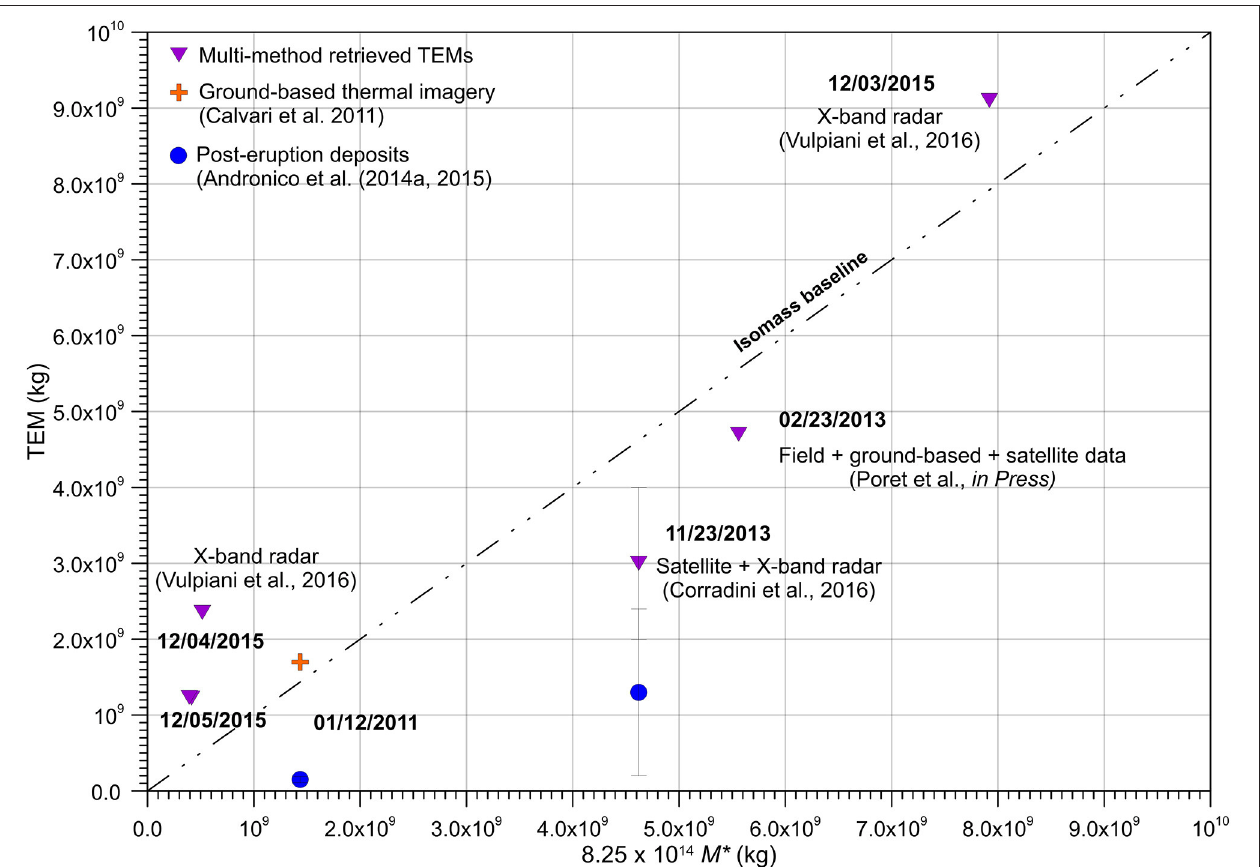
FIGURE 9 | Total Erupted tephra Mass (TEM) at Etna as a function of the calibrated mass proxy M * from the VOLDORAD 2B radar parameters. The isomass baseline appears as a dashed line. Purple triangles correspond to the mass obtained from X-band radar during four paroxysms of the VOR Crater in December 2015 (Vulpiani et al., 2016), X-band weather radar and satellite during the 23 November 2013 paroxysm (Corradini et al., 2016), and from an integration of field, dispersion model, ground-based and satellite data during the 23 February 2013 event (Poret et al., in press). Orange cross corresponds to the TEM retrieved from ground-based infrared imagery on the 12 January 2011 (Calvari et al., 2011). Blue dots show the results from post-eruption deposit analyses the 12 January 2011 and the 23 November (Andronico et al., 2014a, 2015).